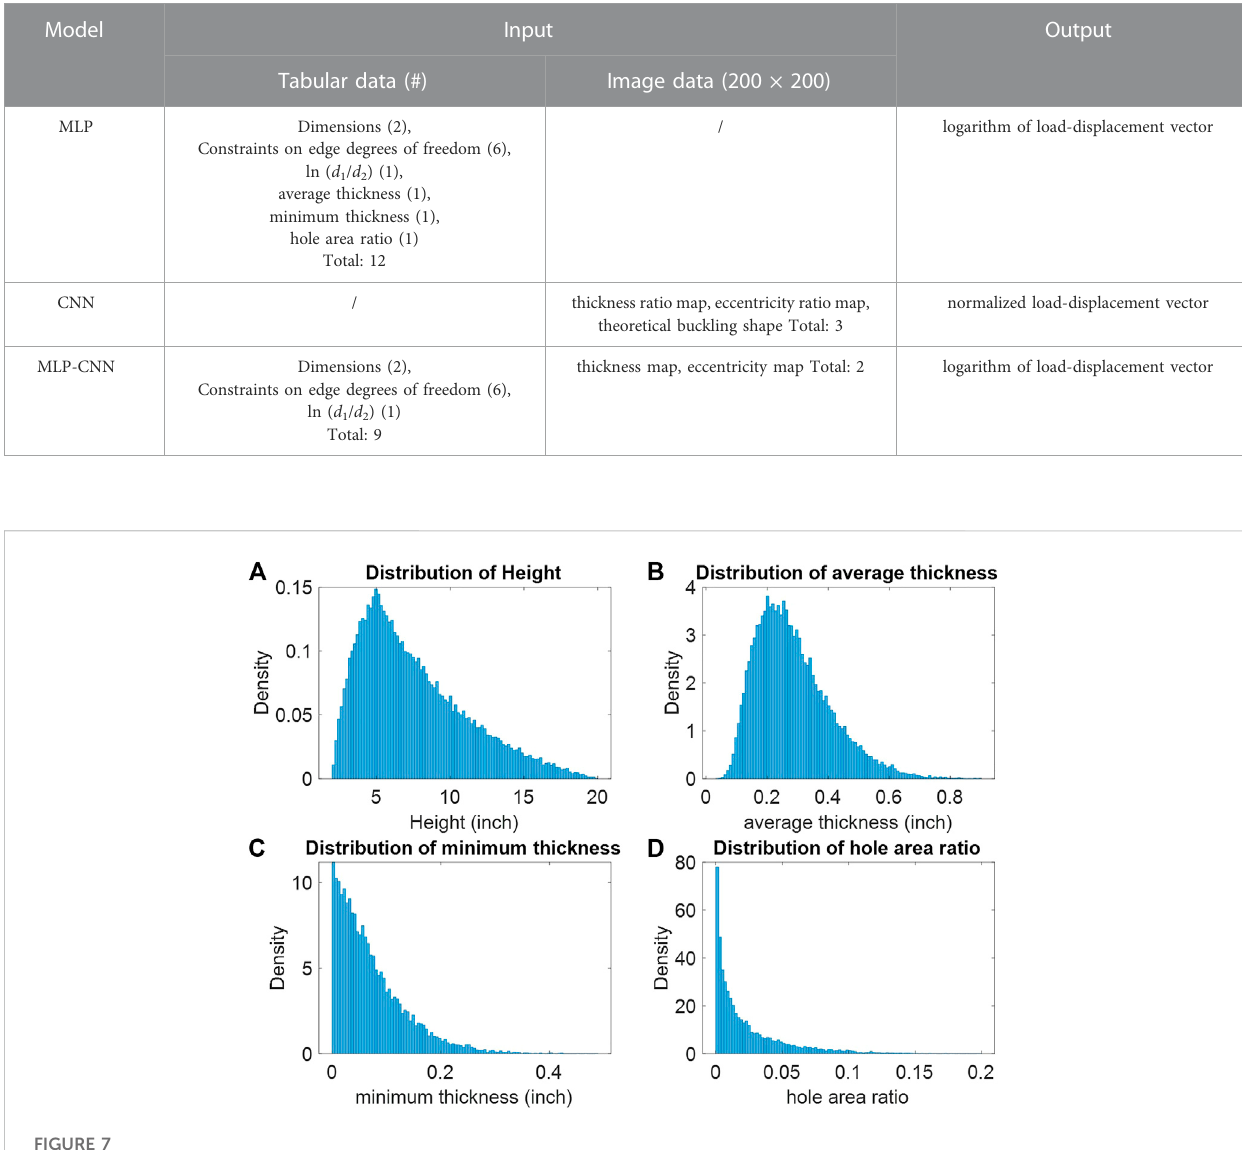
FIGURE 7 Statistical distributions of tabular input data. (A) Histogram of plate heights, H, contained in the training dataset, (B) Histogram of the average plate thicknesses contained in the training dataset, (C) Histogram of the minimum plate thicknesses contained in the training dataset, (D) Histogram of the hole-area ratios contained in the training